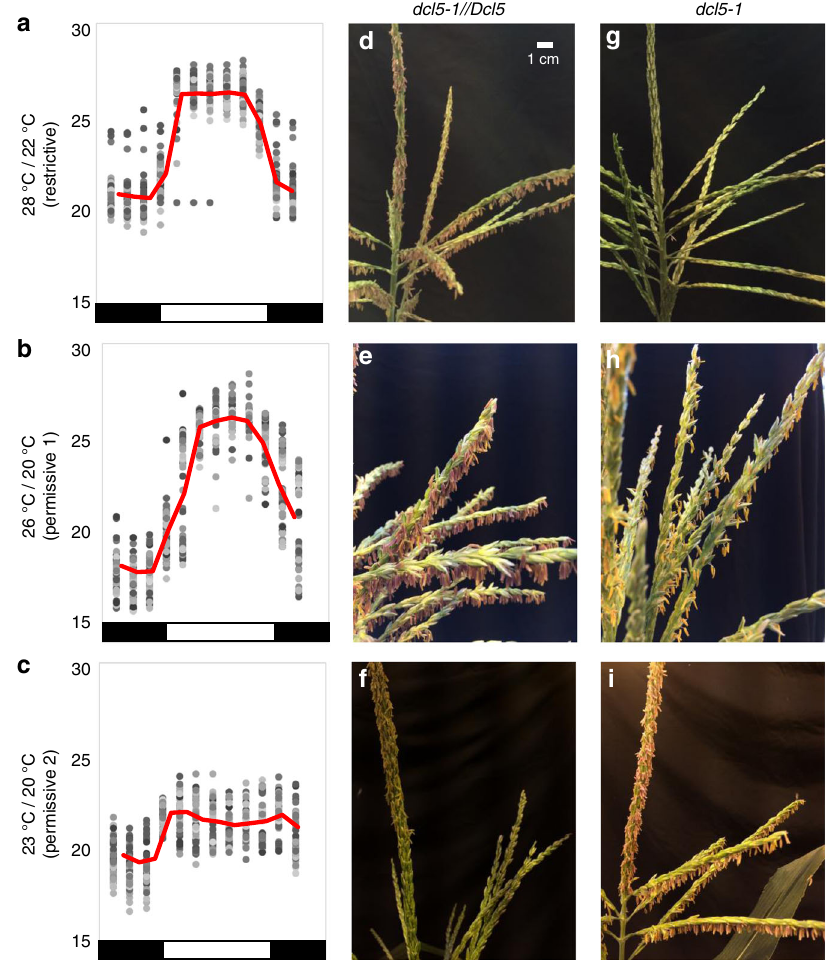
Fig. 4 dcl5-1 anther fertility is temperature sensitive. Three sets of dcl5-1 and sibling dcl5-1//Dcl5 plants grown in greenhouses with differing temperature regimes: 28/22 °C, 26/20 °C, or 23/20 °C (day/night). a – c Temperatures were recorded every 2 h for 60 days (gray dots, average in red; day/night indicated as white or black, below). d – f Heterozygous dcl5-1//Dcl5 siblings were fully fertile under all three regimes. g – i dcl5-1 plants in the restrictive regime ( g ) were completely male sterile, while those in permissive conditions were partially ( h ) or fully ( i ) fertile. Images were taken at 60 ± 3 days after planting (DAP) (top row), 70 ± 2 DAP (middle row), and 71 ± 3 DAP (bottom row); the pace of tassel development is temperature-dependent and full anther exertion occurs at different days after planting, for example f was photographed on the fi rst day of anther exertion, a seven-day process (see “ Methods ” section). The scale bar in d is approximate and pertains to all tassel